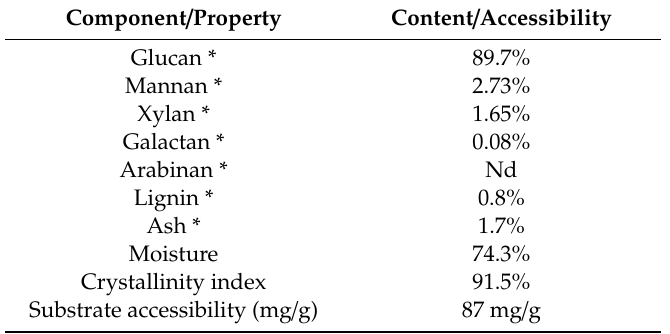
Table 1. Chemical composition as percentage of dry mass basis and structural analysis of paper